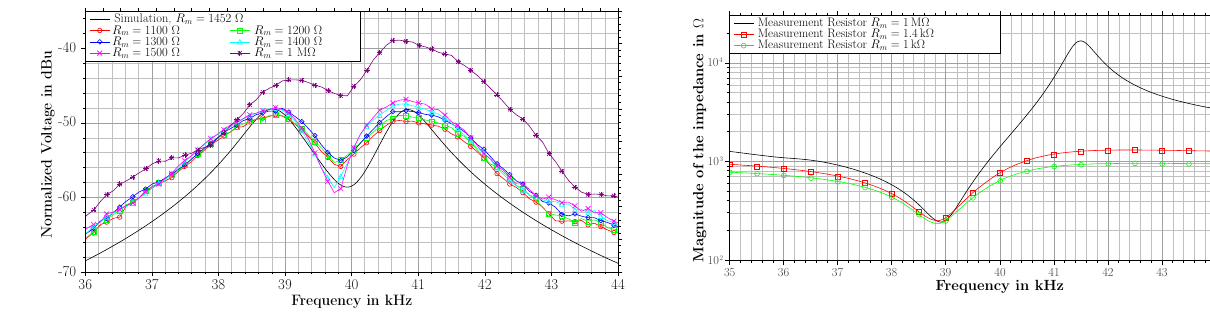
Figure 8. Measurement and simulation results of the voltage at the measurement resistor R m for different values of the R m . The simu- lation (black line) with R m = 1454 (cid:127) coincides with the measured transfer function for the resistor value R m = 1300 (cid:127) .